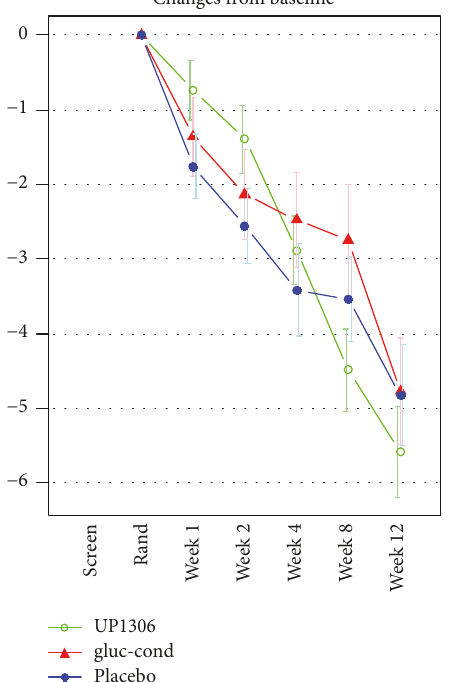
Figure 1: Changes in WOMAC-pain subscore from baseline to week 12. (i) 𝑥 -axis = time-points/ 𝑦 -axis = change in WOMAC-pain